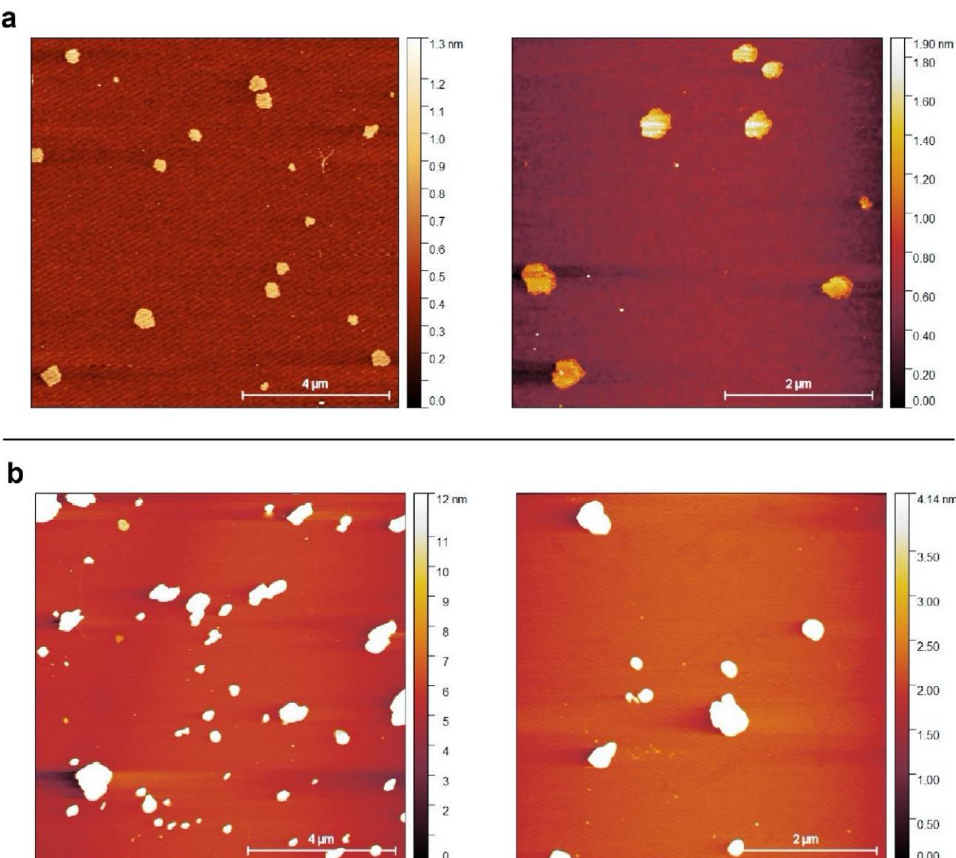
Figure 1. AFM images of BN nanopowder ( a ) and BN nanoplatelets ( b ). BN samples dispersions with a concentration of 20 mg/L were deposited by drop casting on a mica surface.